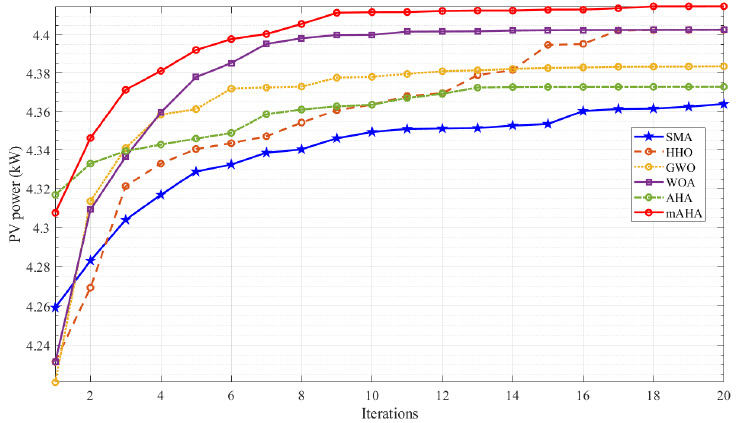
Figure 7. Mean cost function variation during optimization process for second shadow scenario. Table 7. Cost function values during optimization process.